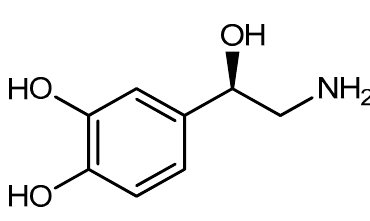
Figure 1. Structure of L-norepinephrine.